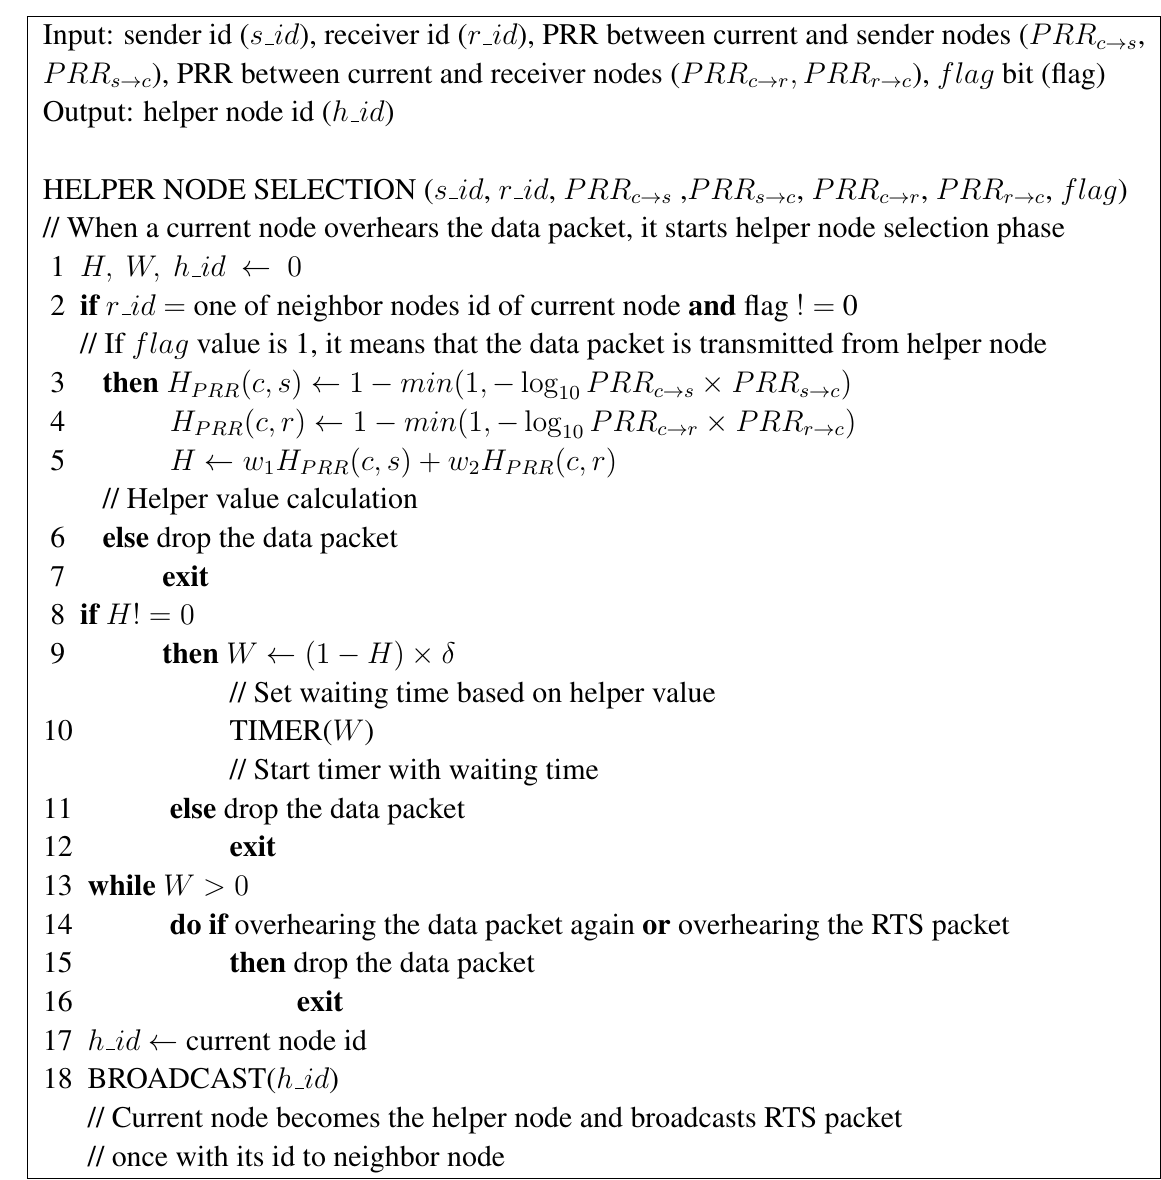
Table 1. Pseudo-code of helper node selection